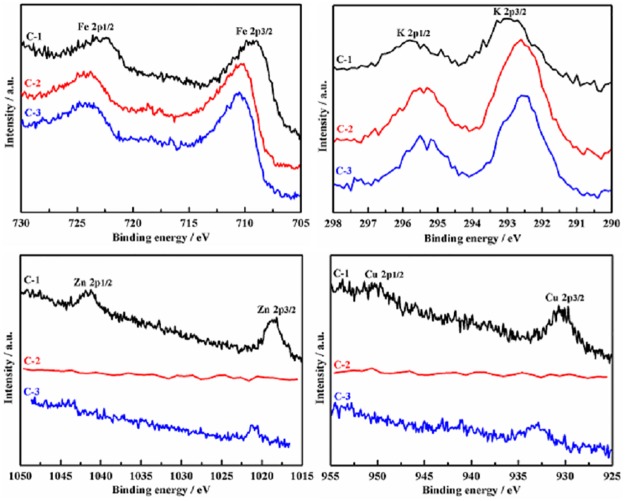
XPS spectra of element Fe, K, Zn and Cu on the catalysts.